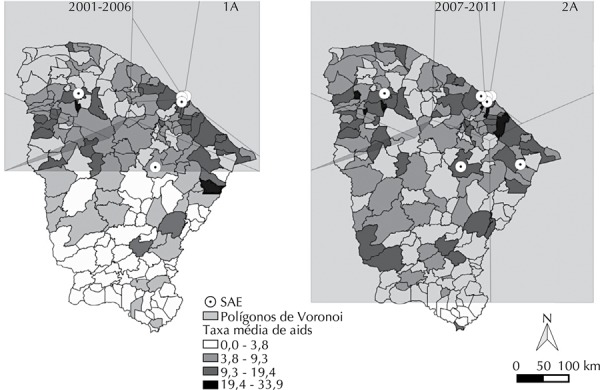
Distribuição de Serviço de Assistência Especializada (SAE) e polígonos de Voronoi. Ceará, 2001-2011.